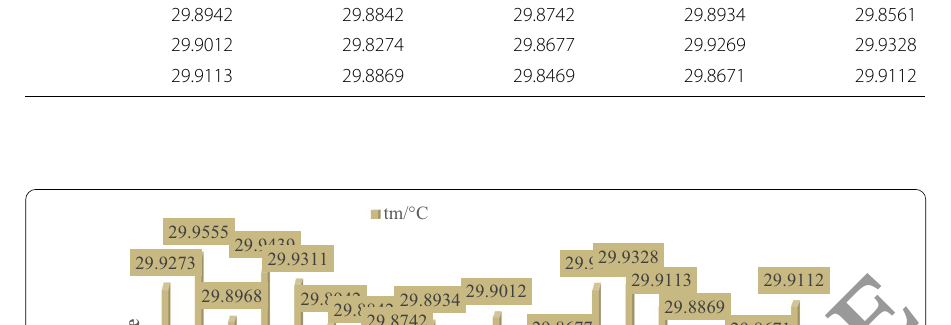
Table 1 Fiber Bragg grating temperature measurement results t m /°C